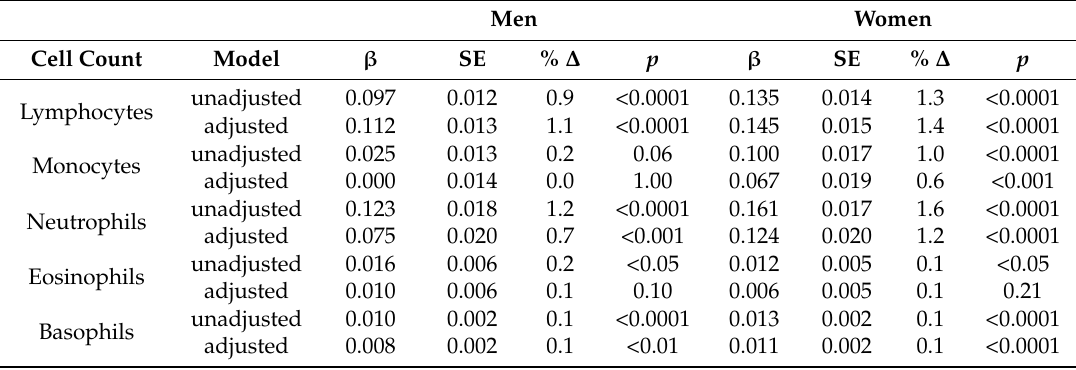
Table 7. Multiple regression models of serum triglycerides predicting changes in peripheral blood leukocyte counts between men and women in NHANES